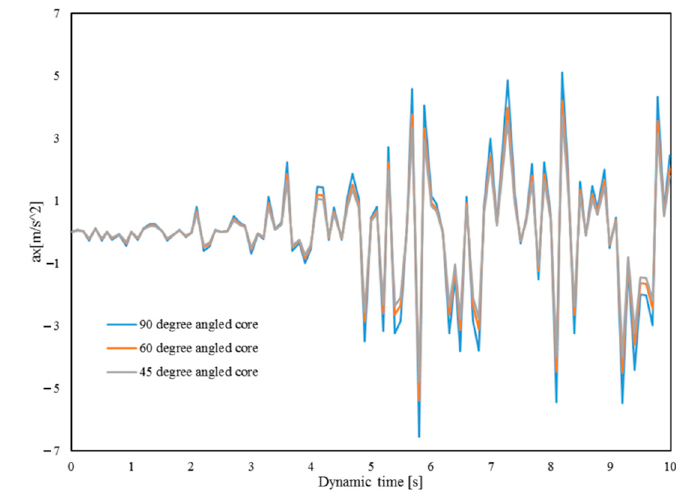
Figure 9. Induction acceleration in the dam’s crest.